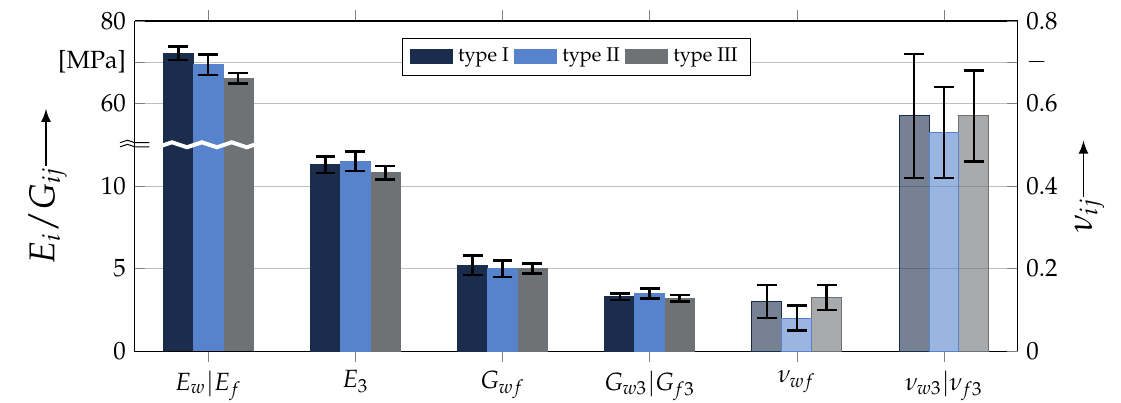
Figure 5. Illustration of elastic properties of ECC-style fabrics/RTM6-2 composite material ( ¯ φ ≈ 60%; see Table A1 for explicit